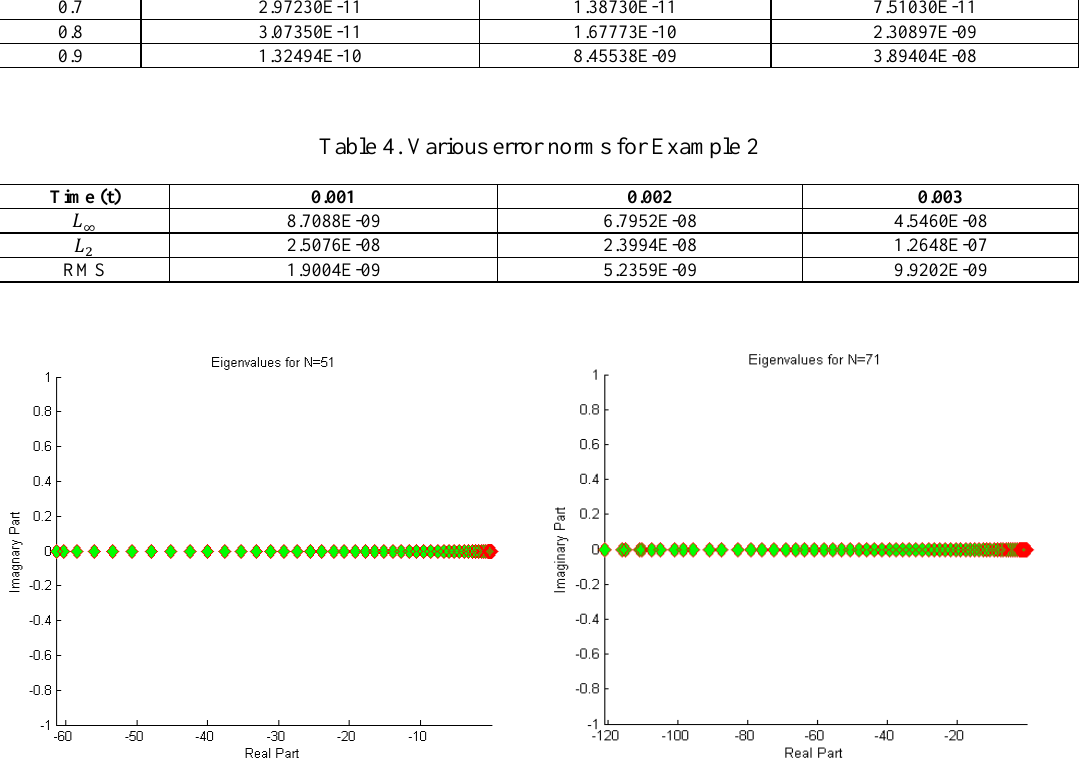
Figure 3. Eigen values of the corresponding matrix of Example 1 for N=51 and